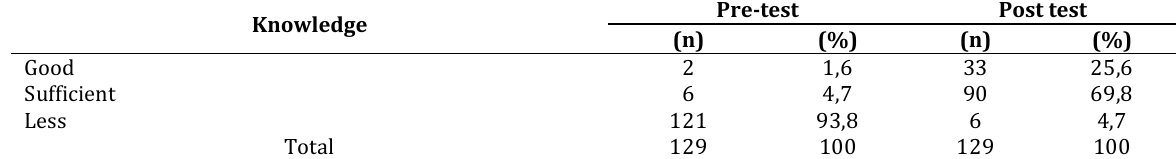
Table 2. Respondents’ Knowledge